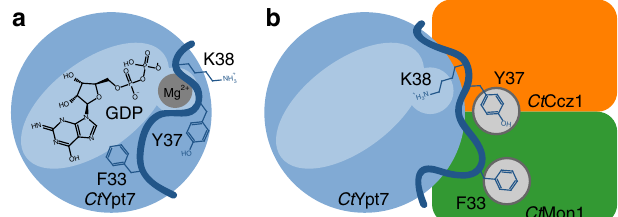
Figure 6 | Model of the nucleotide exchange mechanism by Mon1–Ccz1. ( a ) F33 of Ypt7 interacts with the guanosine base to stabilize nucleotide binding. Switch I closes the binding pocket with Y37 and K38 solvent exposed. ( b ) F33 and Y37 are fixed in hydrophobic pockets on Mon1–Ccz1, leading to switch I rearrangement and opening of the nucleotide-binding pocket. In addition, K38 of Ypt7 is inserted into the nucleotide pocket, repelling with its positively charged terminal amine group the Mg 2 þ cofactor ion from the binding